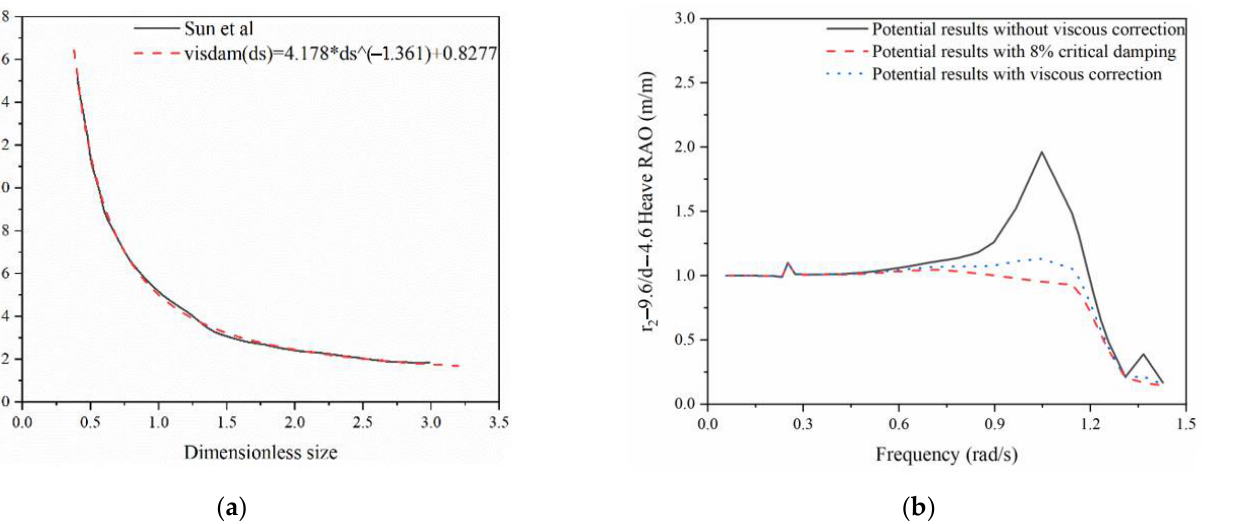
Figure 11. Viscous damping correction for WEC. ( a ) Viscous Damping Correction Mathematical Expression. ( b ) Heave RAO with different viscous damping corrections.